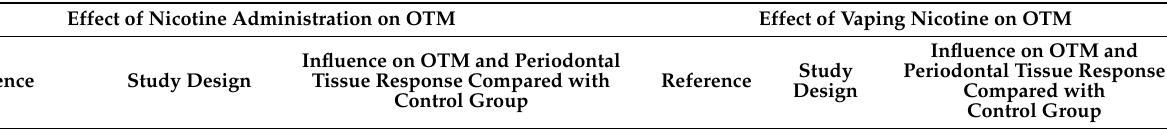
Table 1. Studies evaluating the effect of nicotine administration and/or vaping nicotine on the rate and biology of orthodontically induced tooth movement and periodontal tissue response. OTM, orthodontic tooth movement; OIIRR, orthodontically induced inflammatory root resorption.